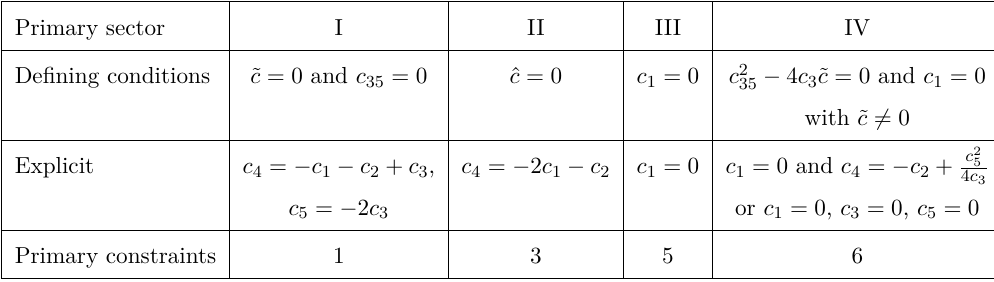
Table 1 . Defining conditions and properties of the primary sectors